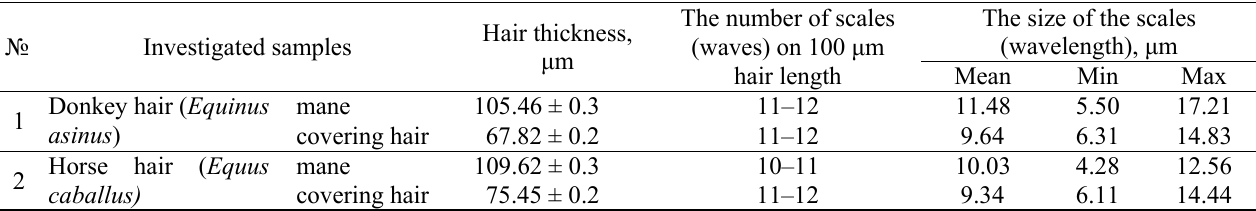
Morphometric characteristics of Equinus asinus and Equus caballus hair (n =